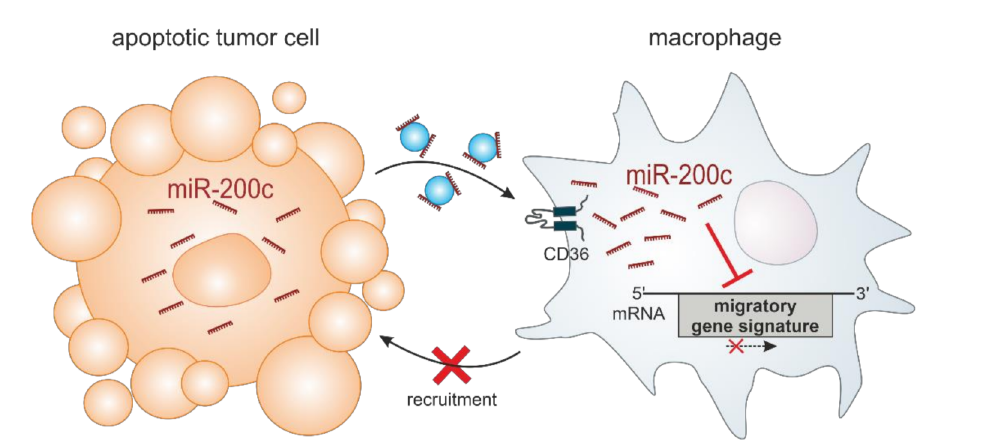
Figure 5. Model of the role of miR-200c in the interaction between tumor cells and M Φ . miR-200c is released from apoptotic, miR-200c-expressing tumor cells and taken up by M Φ via the CD36 receptor. In M Φ , miR-200c reduces the expression of a migration-associated gene signature, consequently limiting the tumor-infiltrating capacity of the M Φ